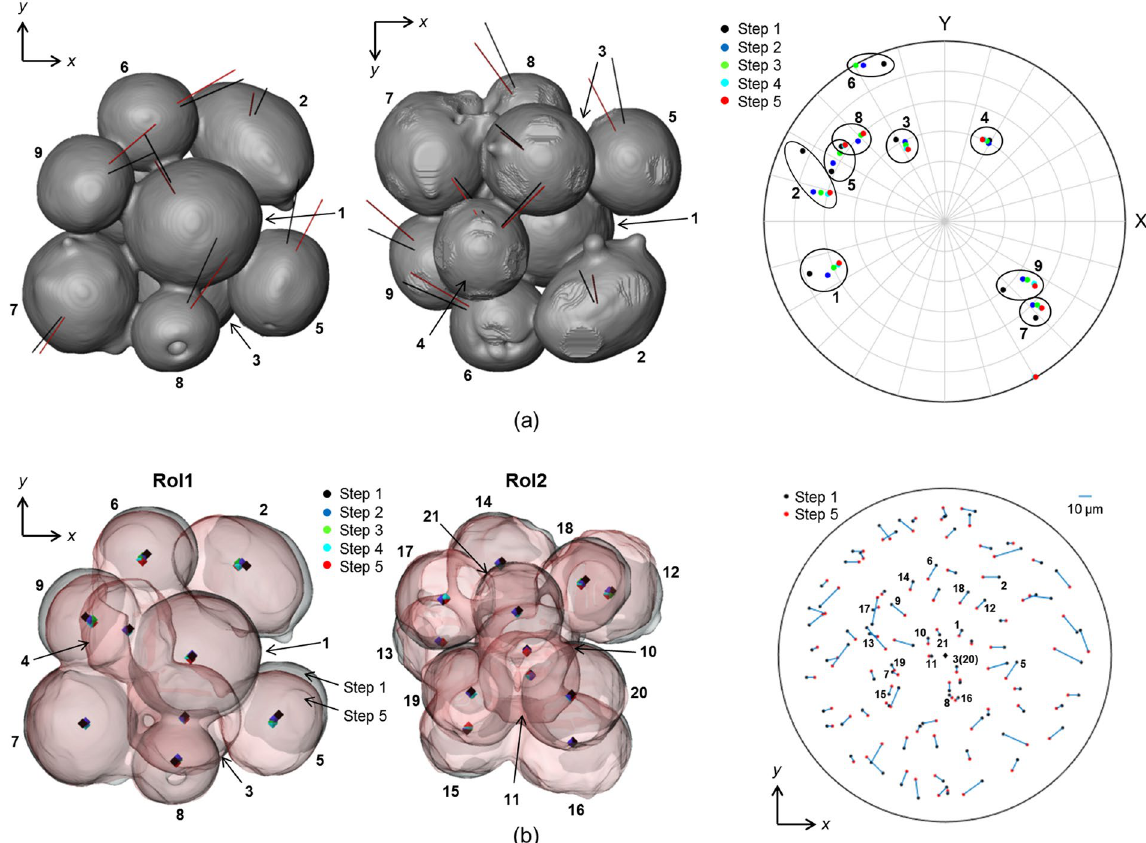
Figure 4. Visualization of particle rotations and their rotation ‘paths’ and particle translations. ( a ) Left and centre images: 3D isosurface rendering of the particles in RoI1 with vector lines representing the rotation axes of the grains within the particles (related to Fig. 3(b)) for step 1 (black lines) and step 5 (red lines). Note: the images represent different views (from above and below, respectively). Right-hand image: Spherical projection onto which the rotation axes are plotted for the 9 particles for each of the steps 1 to 5 (distinguished by the different colour labels, as indicated). Note: antipodal symmetry is applied, with the axes all plotted in the upper hemisphere. ( b ) Left and centre images: Plan views (transparent 3D surfaces) of RoI1 and RoI2 each showing sintering steps 1 and 5 overlayed to illustrate the changes in particle positions. Indicated within each particle are the measured particle centres at each step 1 through to 5. Right-hand image: Planar projection showing particle centre trajectories in the horizontal plane for all particles in the